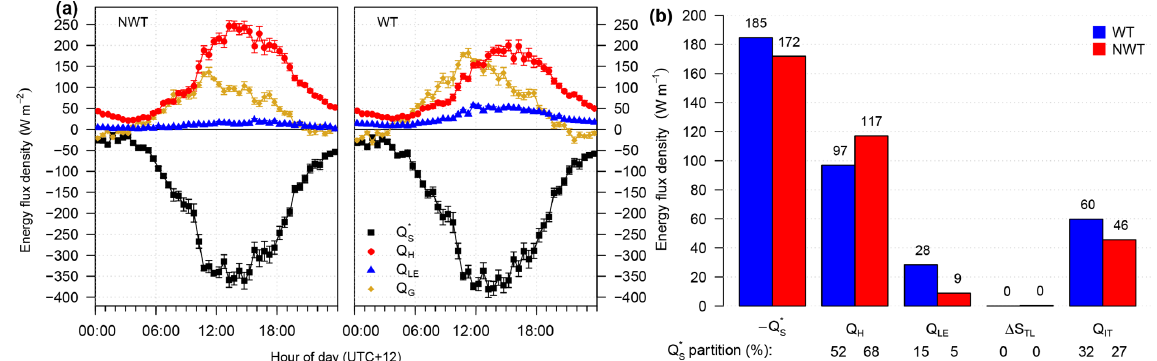
Figure 4. Surface energy balances for NWT (non-water track) and WT (water track) averaged over the whole measuring period, including net radiation ( Q ∗ ), sensible heat flux ( Q H ), latent evaporative heat flux ( Q LE ), and soil heat fluxes. (a) Ensemble mean diurnal variations S including ground heat flux ( Q G ); negative fluxes are directed to the ground surface, positive fluxes away from it; error bars depict standard errors of the mean. (b) Ensemble averages including energy storage change in the thawed layer ( (cid:49)S TL ) and soil heat flux at ice table depth ( Q IT ); partitions of Q ∗ at WT and NWT are added as a percentage for each heat S